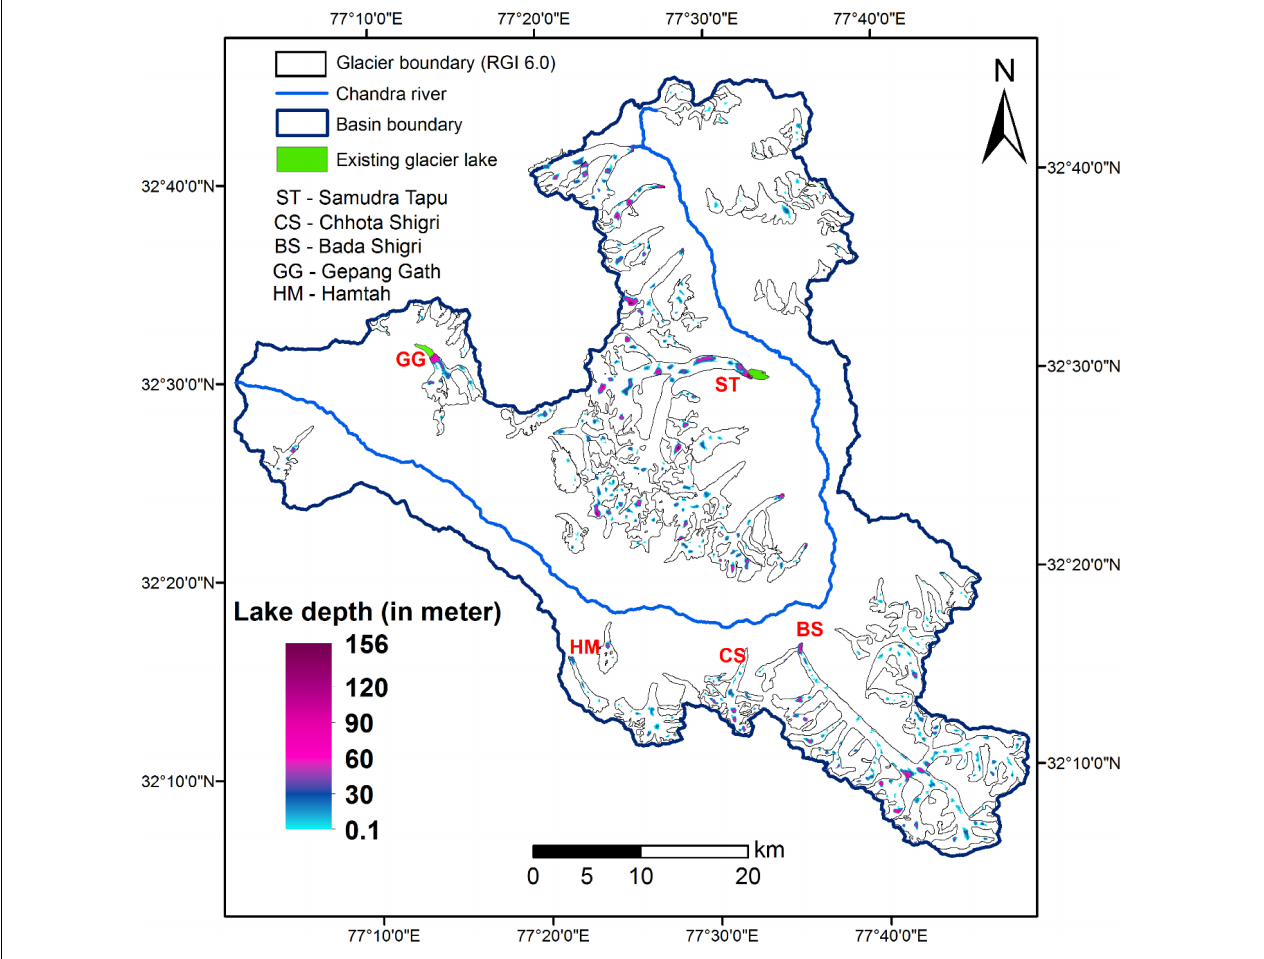
FIGURE 8 | Potential sites for future glacial lake formation in all 65 study glaciers of the Chandra basin. TABLE 4 | Elevation zone-wise potential future glacial lake information for all the 65 study glaciers. Total lake volume Number of lakes at the Elevation zone Number of Total lake area (m a.s.l.) lakes (km 2 ) (km 3 ) tributary of a glacier